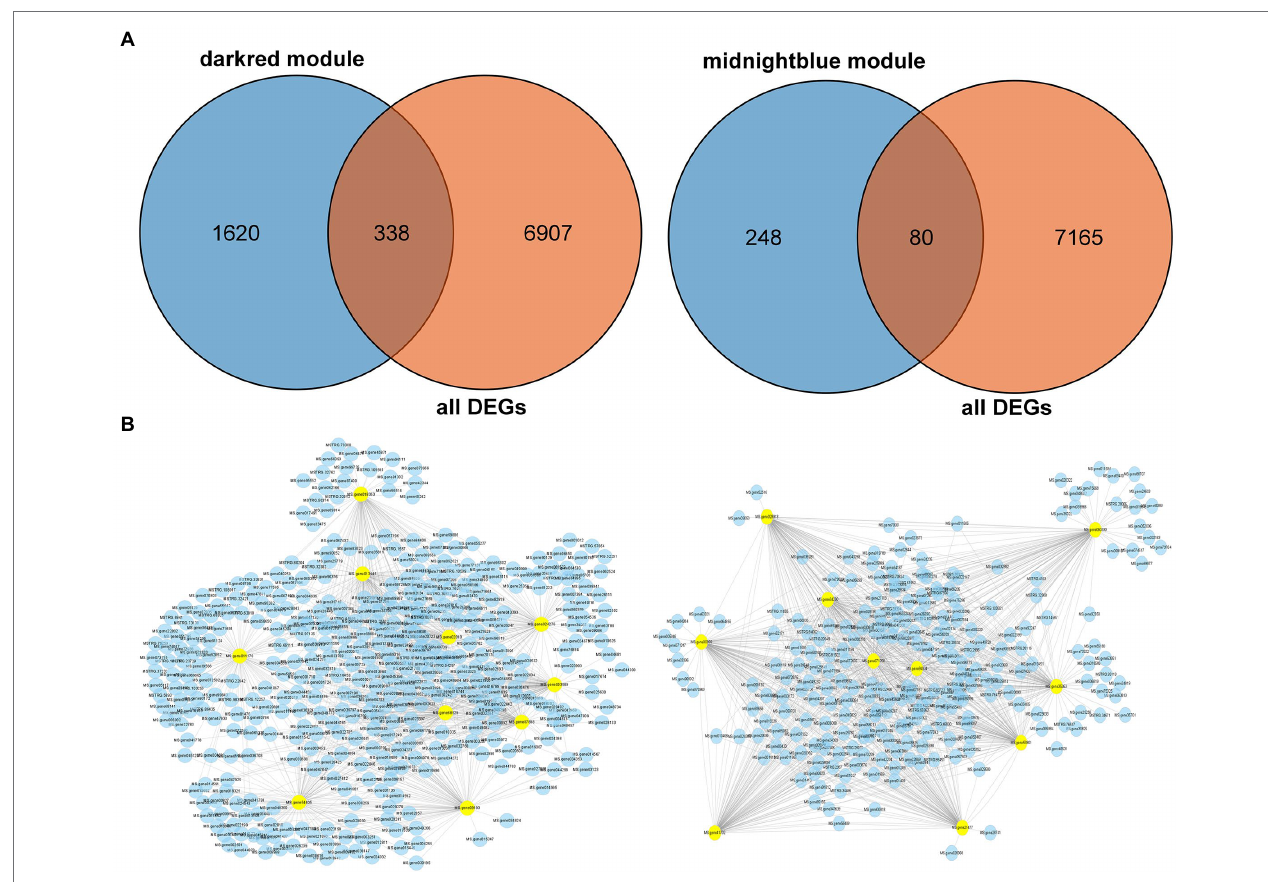
FIGURE 7 | Identification the hub genes of differentially expressed genes (DEGs) in the two key modules. (A) Venn diagram between the two modules and all DEGs. (B) Correlation networks of hub genes corresponding to the darkred and midnightblue modules, respectively. One hundred genes of edge weight in the top 10 hub genes are visualized using